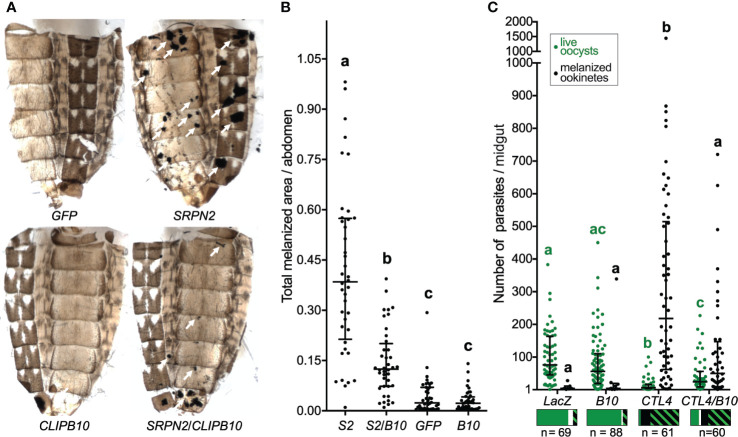
CLIPB10 knockdown partially reverts dsSRPN2- and dsCTL4-induced phenotypes. (A) Abdominal images were collected 21 days post dsRNA injection. Melanotic tumors are indicated by white arrows. (B) Total melanotic areas per abdomen (arbitrary unit) were quantified by Image J. Median and interquartile range are marked (n = 40). Kruskal-Wallis test followed by Dunn’s multiple comparison test were performed to calculate statistical significance. Medians with a common letter are not significantly different (P > 0.05). (C) Live GFP-expressing oocysts (green circles) and melanized ookinetes (black circles) per gut were scored. Median and interquartile range are marked (n, number of guts examined per treatment group). Both oocyst and melanized ookinete infection intensities, respectively were statistically significantly different between all treatment groups (Kruskal-Wallis test P < 0.0001). Medians with a common letter are not significantly different (Dunn’s multiple comparison test, P > 0.05), with letters in green indicating live oocyst comparisons, and letters in black indicating melanized ookinetes (see Table S3 for complete summary statistics). The bar charts below each treatment group show prevalence as the fraction of guts containing live oocysts only (green), melanized ookinetes only (black), both live oocysts and melanized ookinetes (green/black hatch), and no parasites (white). The statistical analyses of the prevalence data are summarized in Table S4.